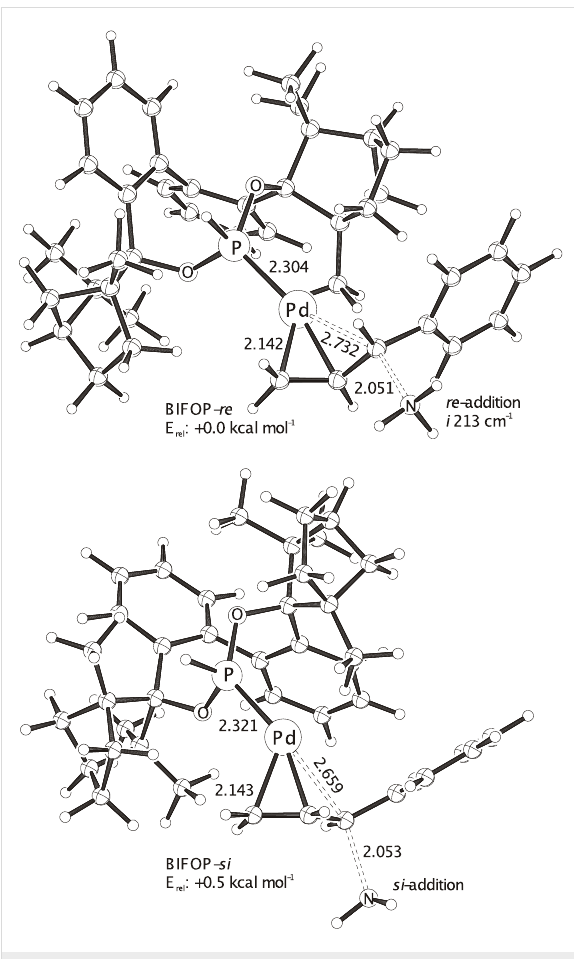
Figure 5: The two most stable ONIOM(B3LYP/SDD(+ECP) (Pd) / 6-31G* (C, H, O, N, P) : UFF) optimized transition structures with BIFOP-H , due to systematic conformational analysis (60° rotations at P-Pd). ZPE (unscaled) corrected total extrapolated energies: BIFOP- H- re : -1025.01553 H, BIFOP-H- si : -1025.01466 H. The by 0.5 kcal mol -1 slightly preferred re -addition of the NH 3 model nucleophile corresponds to the experimental S -alkylation